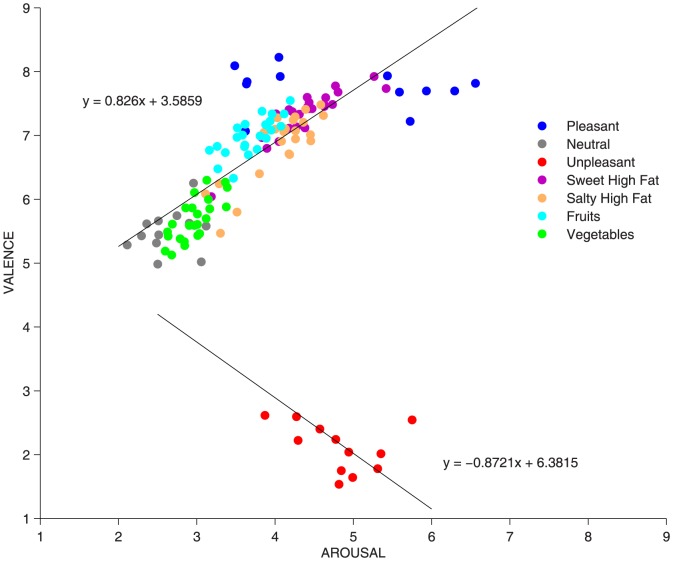
Affective Space.Bidimensional plot of each affective or food image as a function of its mean valence and arousal ratings. Each point in the plot represents the valence and arousal ratings for an IAPS (red, gray, and blue) or food picture (plotted in different colors, based on food category). The position within the “affective space” of all food and IAPS pictures display the “boomerang” shape repeatedly reported in emotion research. Regression lines are plotted separately for appetitive (valence ratings>5) and defensive contents (valence ratings <5). All food and pleasant images are located on the upper arm of the boomerang, assumed to reflect the appetitive motivational system, while fewer unpleasant images are located in the lower arm of the boomerang, corresponding to the defensive motivational system. Among the food pictures, it can be appreciated that pictures depicting vegetables lie closer to neutral contents while pictures depicting sweet high-fat foods are located closer to pleasant IAPS images.